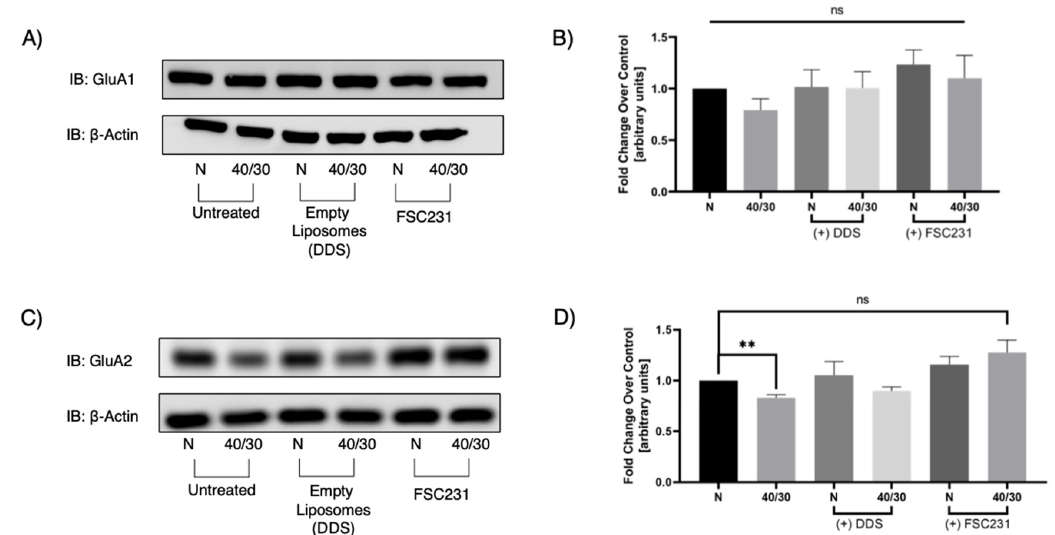
Figure 5. FSC231 prevents OGD/R-induced interaction of PICK1 and GluA2. ( A ) Representative Western blot of PICK1 indicating that PICK1 protein levels are unchanged with OGD/R in hippocampal slices. ( B ) Quantification of Western blots represented in ( A ). ( C ) Representative Western blot demonstrating that 40 min of OGD and 30 min of reperfusion increases the association between PICK1 and GluA2. FSC231 treatment prevents the OGD/R-induced increase in PICK1–GluA2 interaction. ( D ) Quantification of post-OGD/R immunoprecipitation of PICK1 and subsequent immunoblotting for GluA2 normalized the normoxic untreated control. N = 12, one-way ANOVA with post hoc Sidak; * denotes p < 0.05; ns denotes no significance.